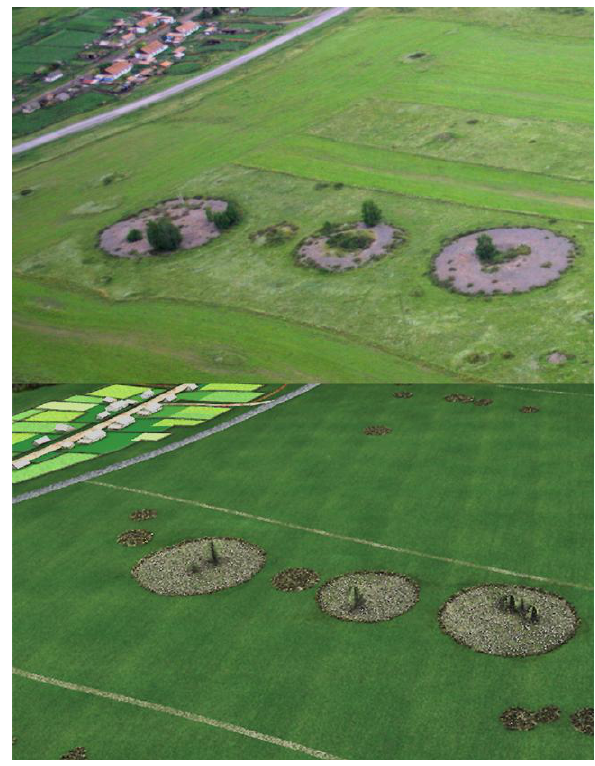
Figure 5: Kurgans near Tuekta as seen by a real and a virtual camera (aerial photograph by J. Bourgeois, Ghent University, 2007).